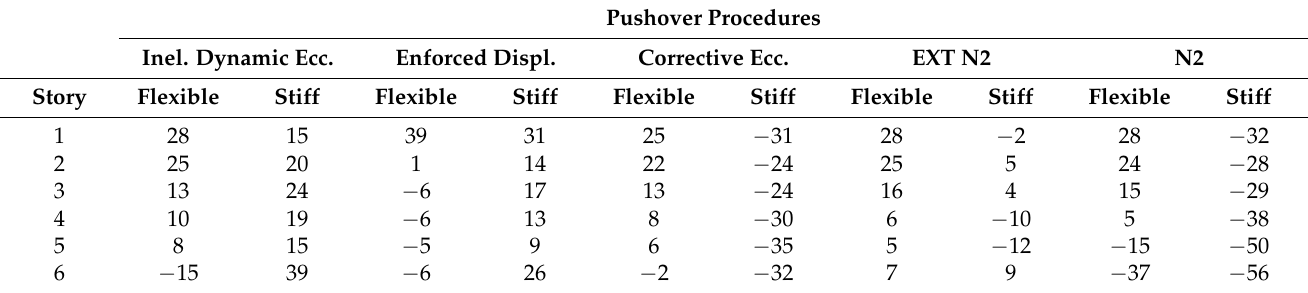
Inel. Dynamic Ecc.